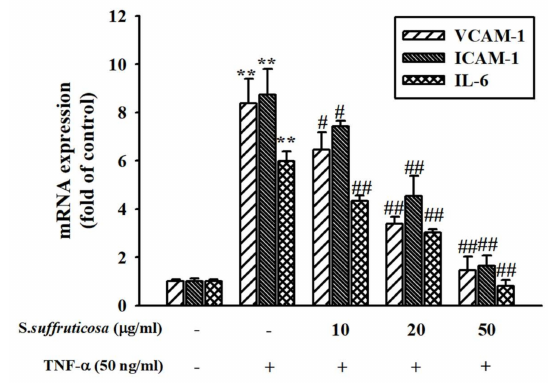
Figure 5. E ff ect of Securinega su ff ruticosa on TNF- α -induced vascular inflammation related molecule mRNA expression. HUVEC were pretreated with Securinega su ff ruticosa (10–50 µ g / mL) for 30 min and then stimulated with TNF- α (50 ng / mL) for 24 h. VCAM-1, ICAM-1 and IL-6 mRNA expressions were analyzed by using real-time RT-qPCR (Quntitative reverse transcription polymerase chain reaction). ** p < 0.01 vs. non-treated control group, # p < 0.05, ## p < 0.01 vs. TNF- α treated